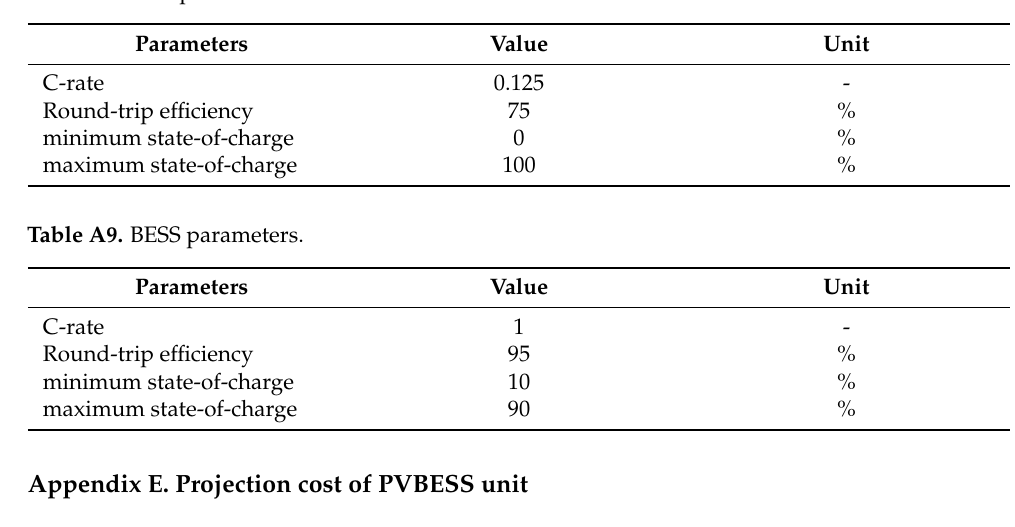
Table A8. PHS parameters.